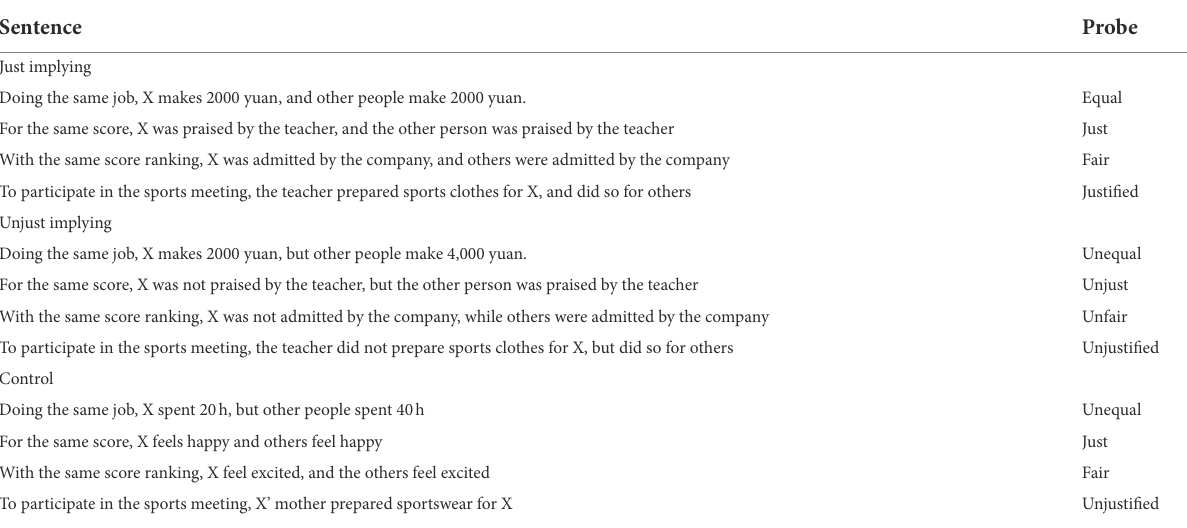
Table A1 Experimental sentences and the subsequent probes used for the experimental trials in Experiment 1 and 2.